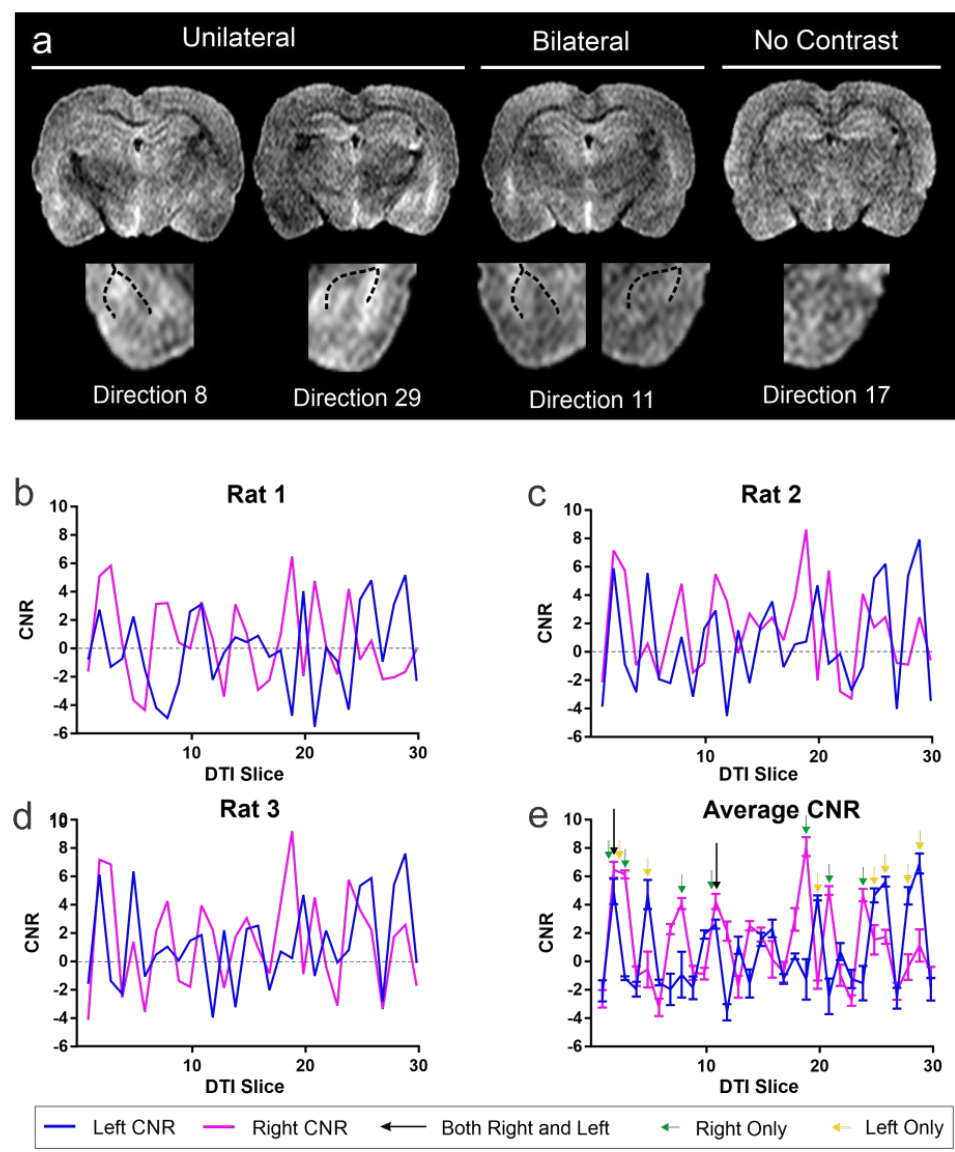
Figure 3. Optimal diffusion tensor directionality for identification of the basolateral complex of the amygdala. ( a ) Examples of directional diffusion tensor images wherein either left, right (unilateral) or bilateral BLA appear to have increased contrast. A tensor image in which there is no enhanced contrast within the BLA is also shown. The dotted lines demarcate the external white matter boundaries of the external capsule that bound the BLA in the temporal lobe. See also Supplementary Figure S1. ( b ) Contrast-to-noise ratio (CNR) measures at the level of the BLA (Bregma, − 3.30 mm) from each directional vector (see a ) demonstrate remarkable consistency between three animals ( b–d ) in enhanced contrast in directional tensor images. ( d ) CNR measures were then averaged across all three brains to identify the optimal unilateral or bilateral CNR in the BLA. ( e ) Green arrows indicate optimal CNR in the right BLA, while yellow arrows identify the optimal directions for the left BLA. Two directions (2, 11) have optimal CNR in both BLA simultaneously. While there are optimal directions for either the left or right BLA only, there are two directional DTI images which produce the highest CNR for both the left and right BLA within the same MR image and with the least variance (direction 2 and 11). (See Supplementary Figure